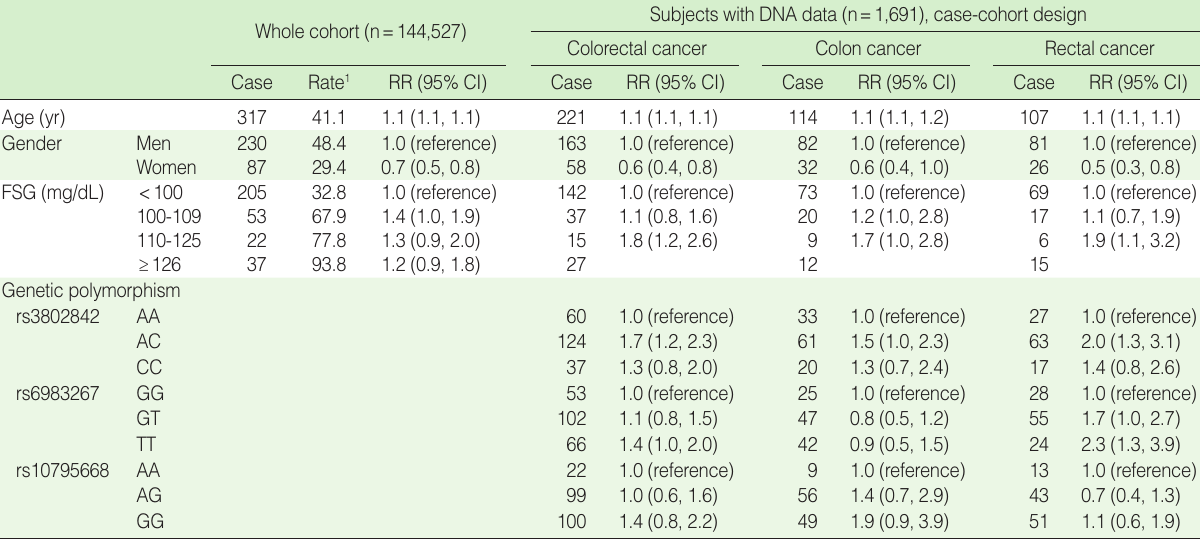
Table 2. Risk factors for colorectal cancer incidence as analyzed by Cox proportional hazard models: the Korean Cancer Prevention Study-II Whole cohort